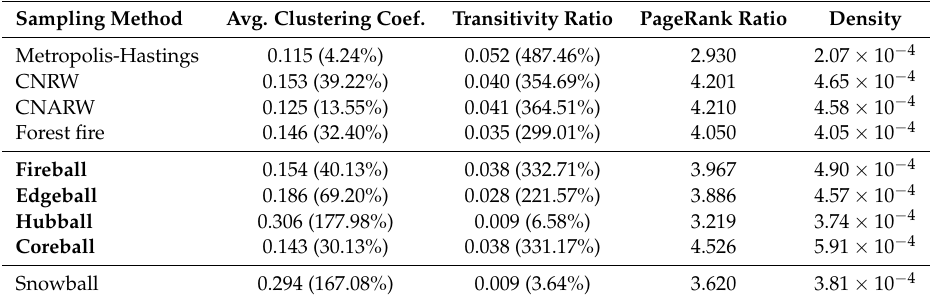
Table 6. Numerical results for the Youtube graph sampled at 10%. Full graph’s average clustering coefficient is 0.11, transitivity ratio is 8.8 × 10 − 3 , density is 1.57 × 10 − 5 . Relative error for the average clustering coefficient and transitivity ratio is shown between